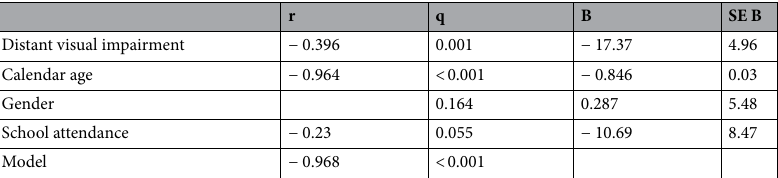
Table 4. Association between visual acuity and Vineland adaptive behaviour. Multivariate analysis of the correlation between the lag in Vineland adaptive behaviour and distant visual acuity impairment adjusting for calendar age, gender and school attendance. r = partial correlation coefficient. q = significance of t-test adjusted for multiple testing with false discovery rate (FDR) correction. B (unstandardized coefficients) = slope. SE B = standard error of the mean of